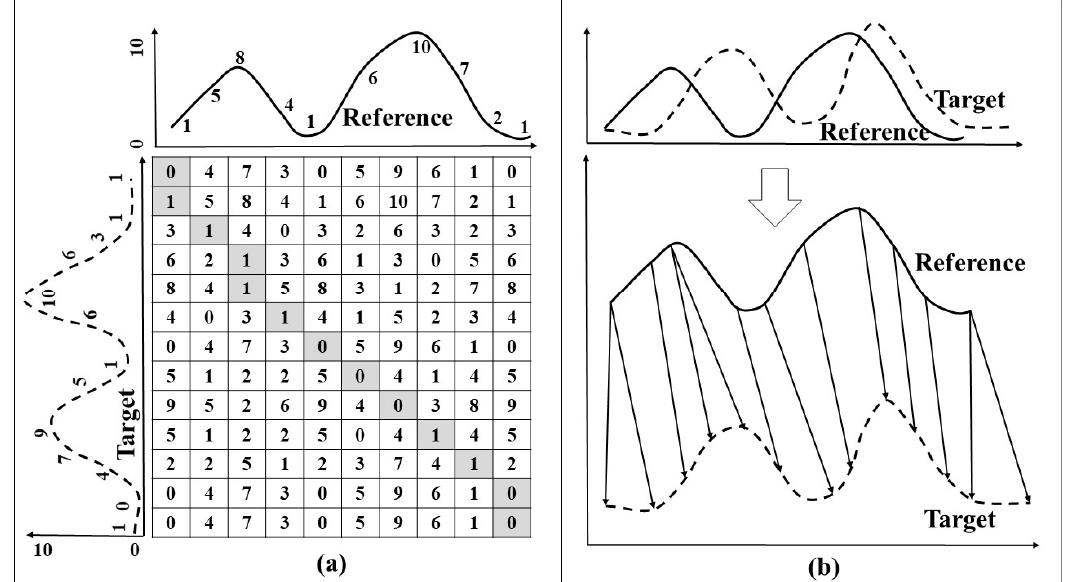
Figure 6. Illustration of the DTW algorithm. ( a ) Distance matrix d and warping path P (gray box) computed by DTW. The numbers on the two curves denote the curve magnitudes. Each number in the boxes denotes the di ff erence between the pair of elements in the reference and target curves. ( b ) Alignment of the two curves determined by DTW.